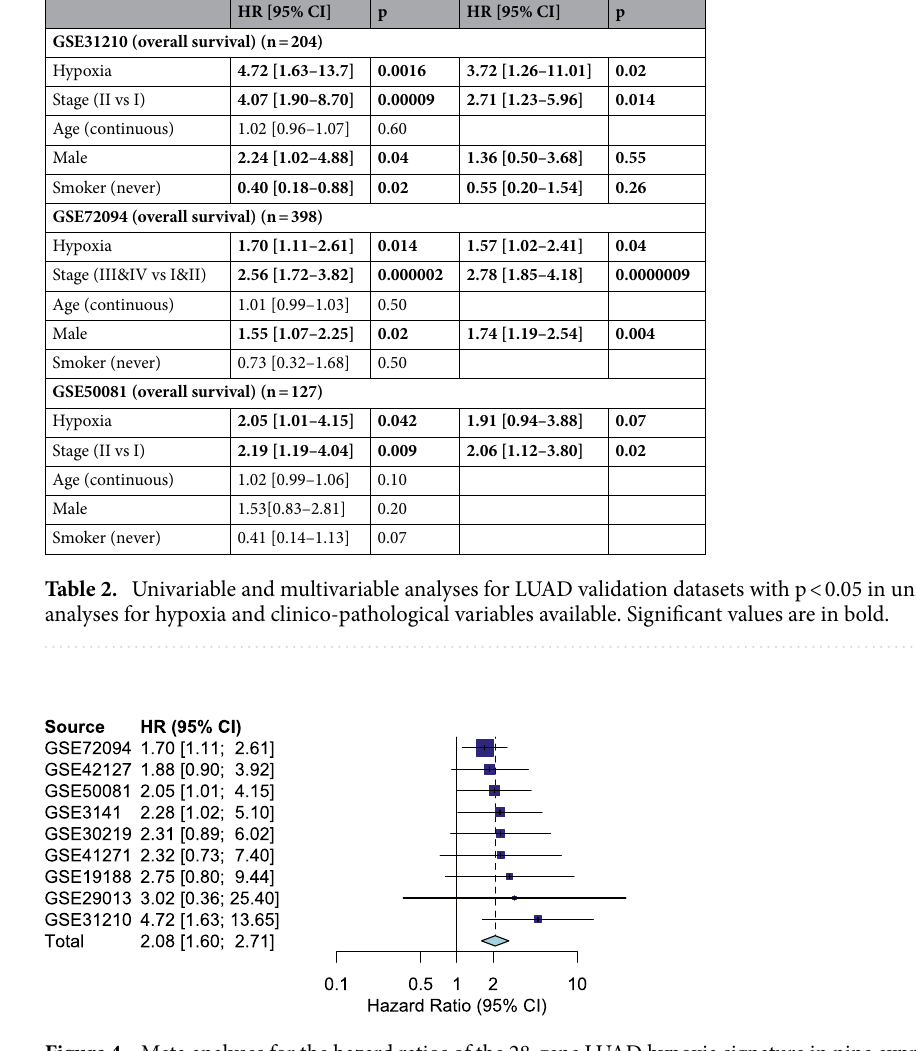
Figure 4. Meta analyses for the hazard ratios of the 28-gene LUAD hypoxia signature in nine expression datasets. A fixed effect model was used with the generic invariance method. LUAD lung